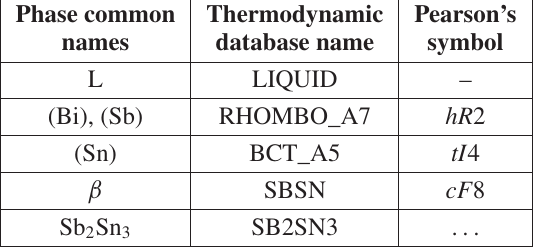
Table 1. Considered phases and their crystal structures [6].